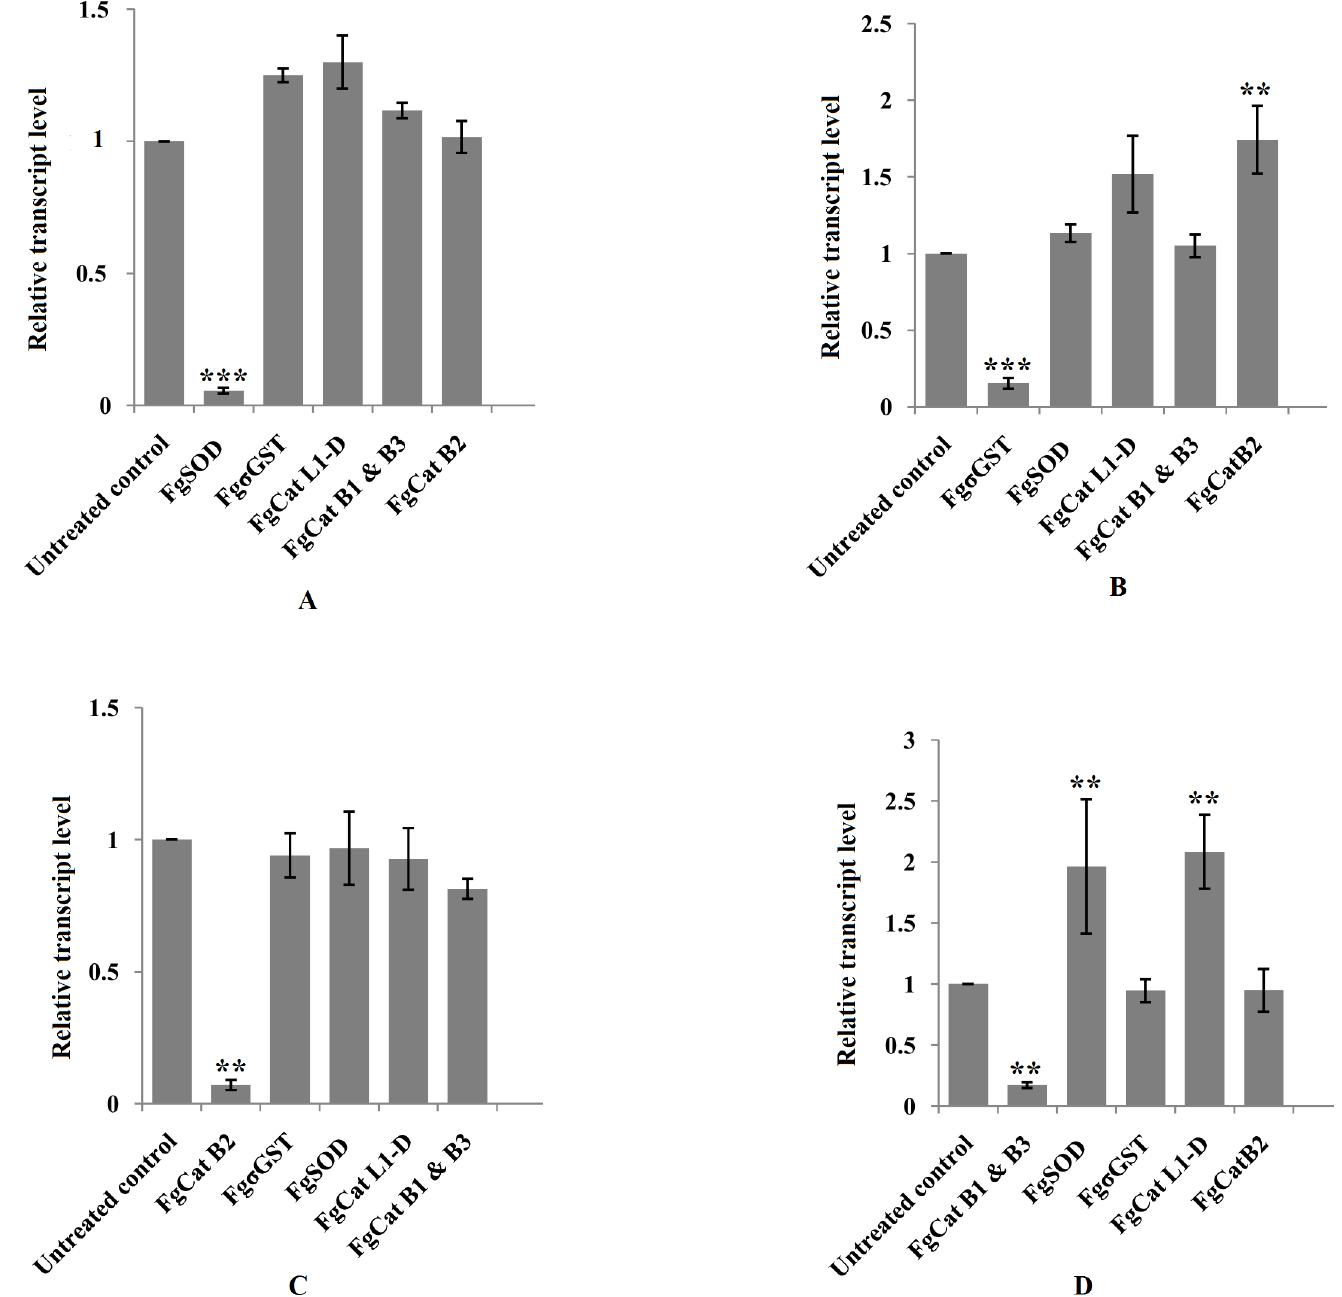
Fig 4. Off-target effects of the treatment of F . gigantica NEJs with SOD (A), σ GST (B), Cat B2 (C) and Cat B1-B3 (D) specific dsRNA trigger on non- targeted mRNA transcripts at 72 h post-RNAi. Results are presented as the mean ± standarderror (SE) of the unit value of 2 −ΔΔ Ct from three independent experiments. P values of (cid:20) 0.05 were consideredsignificant.Experiments were repeated (cid:21) 3 times. Significantdifferences betweendsRNA treated and untreatedcontrol worms are indicated( * , P < 0.05; ** , P < 0.01; *** , P <